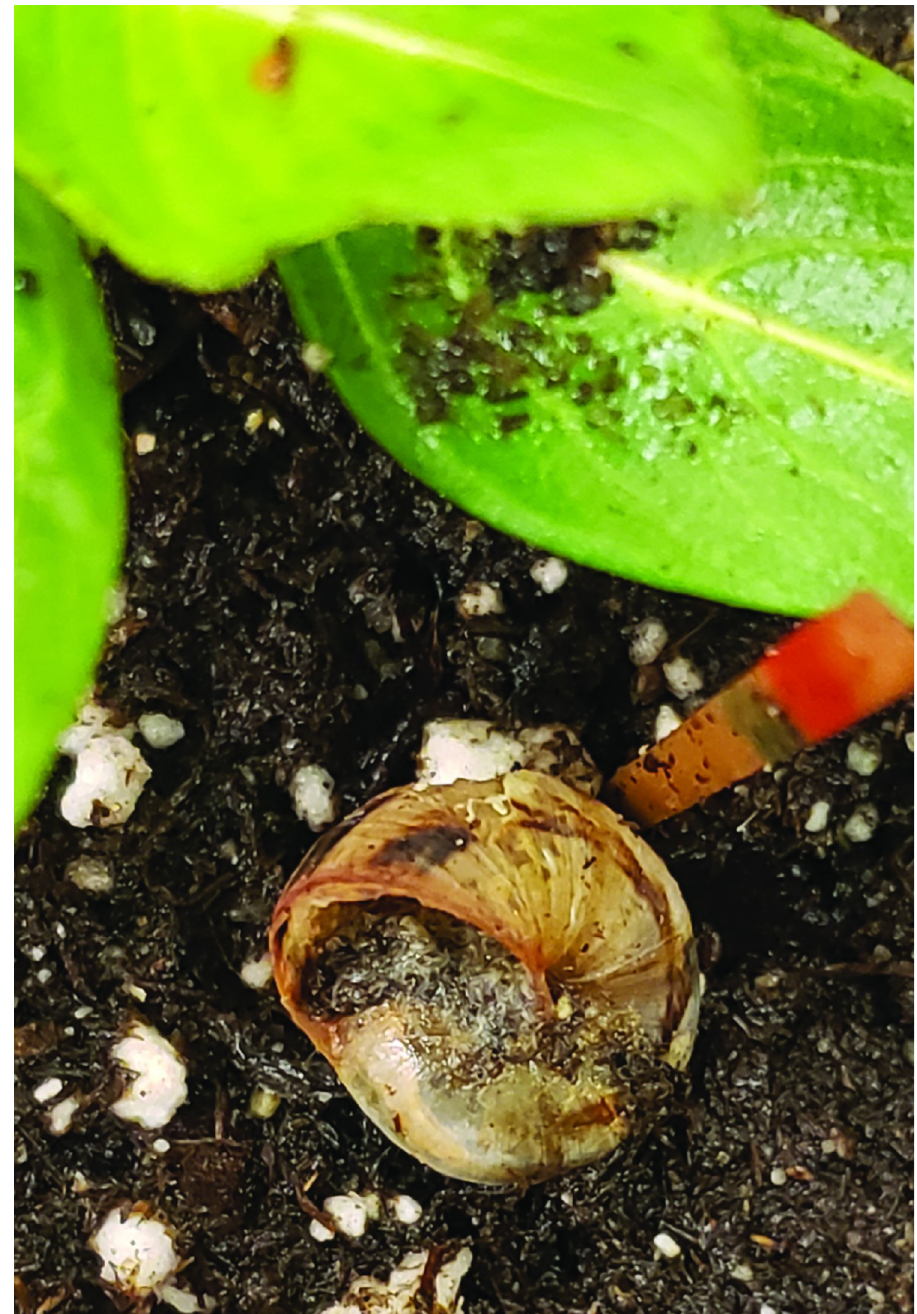
Fig 3. A dead adult Theba pisana snail with mixed stages of Phasmarhabditis californica (ITD726) within the shell cavity. laboratory at room temperature (~23˚C). All arenas were covered with a fabric barrier (Dewitt 3’ x 100’ 6 Year Weed-Barrier Landscape Fabric) to prevent excess light exposure.